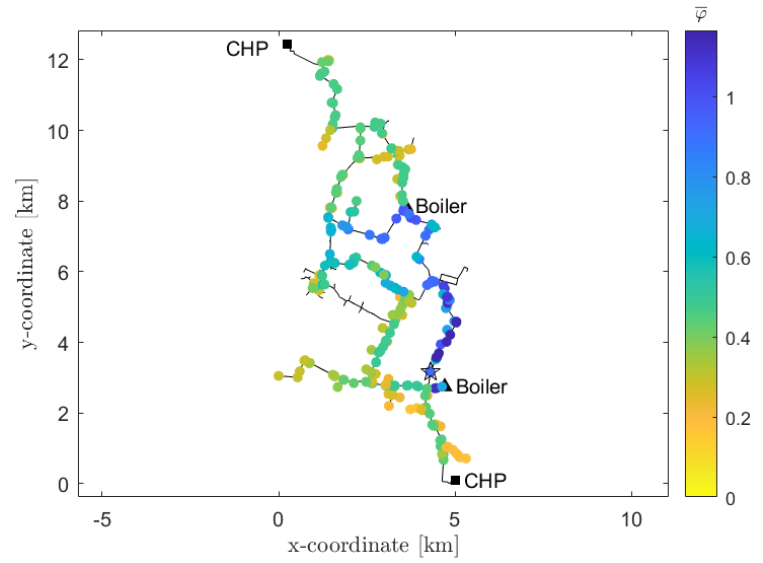
Figure 9. 𝜑̅ coefficient throughout the selected DH system, averaged on the annual operation (the star indicates the best position) − Average yearly operation, base case.